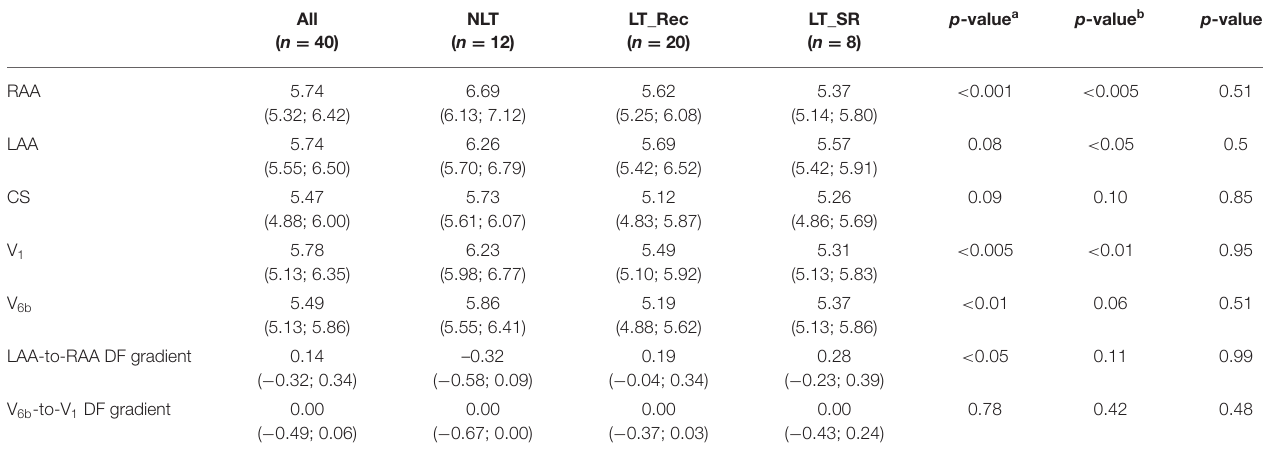
TABLE 2 | Surface ECG and intracardiac electrogram (EGM) DF values at baseline.